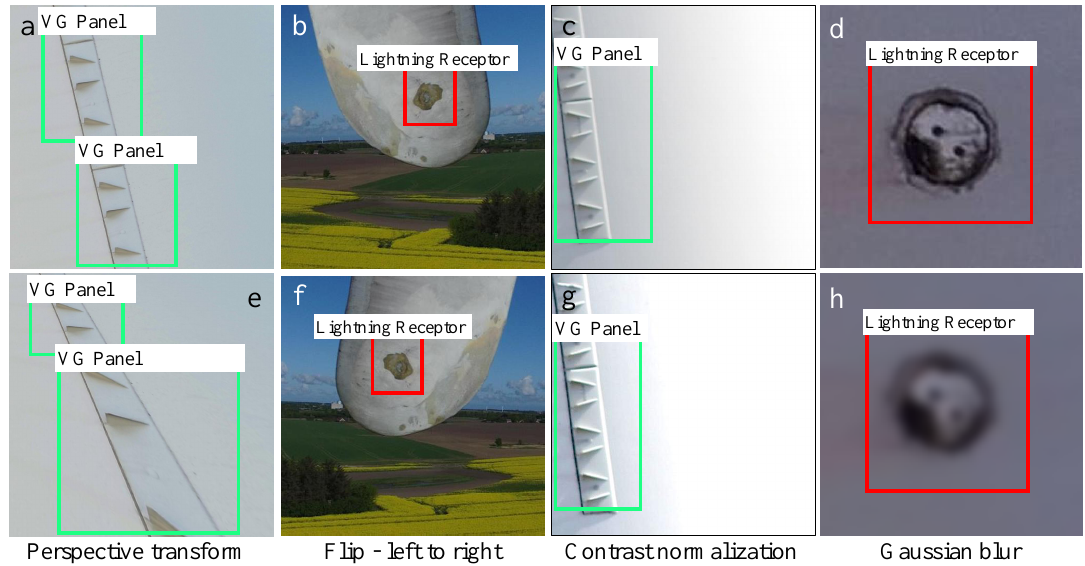
Figure 3. Illustrations of the regular augmentation methods applied to drone inspection